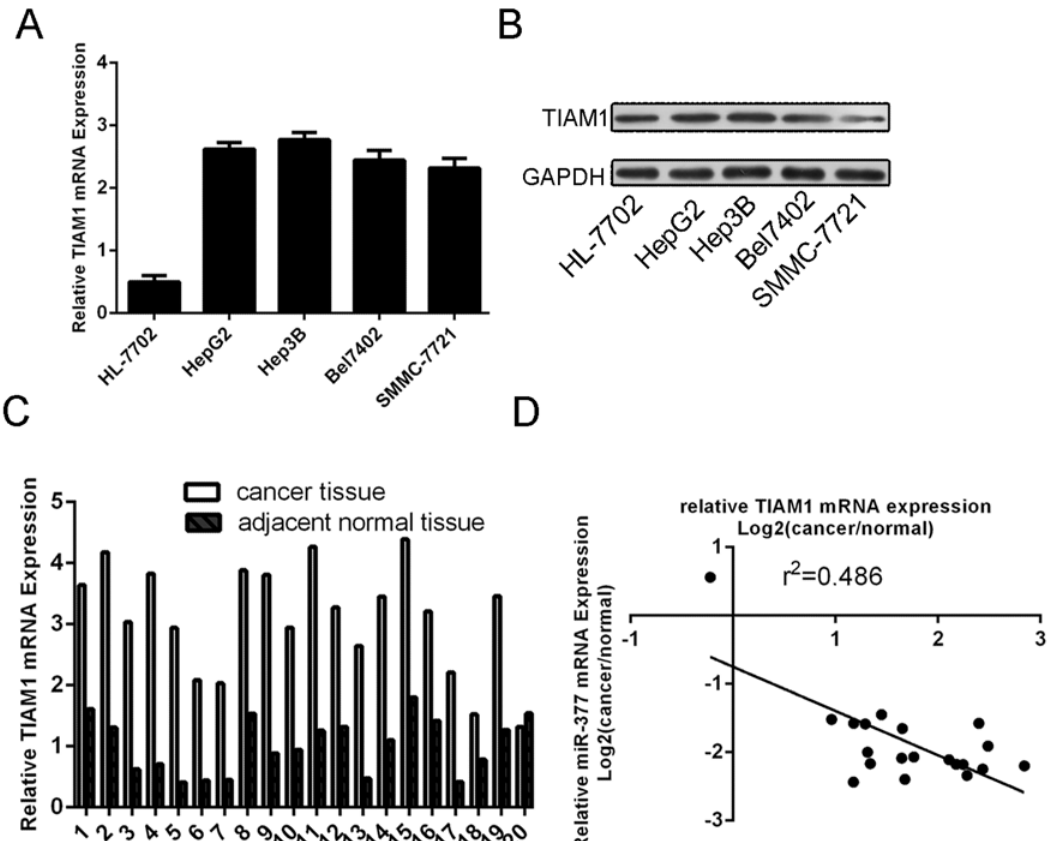
Fig 6. MiR-377 and TIAM1 are inversely expressed in HCC specimens. (A) Relative expression of TIAM1 in four HCC cell lines (HepG2, SMMC7721 Hep3B and Bel7402) and one normal human hepatocyte (HL-7702) was determined by qRT-PCR. GAPDH was used as internal control. (B) Western blotting was performed to examine the TIAM1 protein expression in four HCC cell lines (HepG2, SMMC7721 Hep3B and Bel7402) and one normal human hepatocyte (HL-7702) was determined by qRT-PCR. GAPDH was used as loading control. (C) qRT-PCR analysis of TIAM1 expression in 20 pairs HCC tissues and their corresponding adjacent normal tissues. The expression of TIAM1 was normalized to GAPDH. (D) Analysis of correlation of miR-377 and TIAM1 expression in HCC tissues. (Two-tailed Pearson ’ s correlation analysis, r 2 = -0.486; p < 0.01). Data was presented as log 2 of fold change of HCC tissues relative to non-tumor adjacent